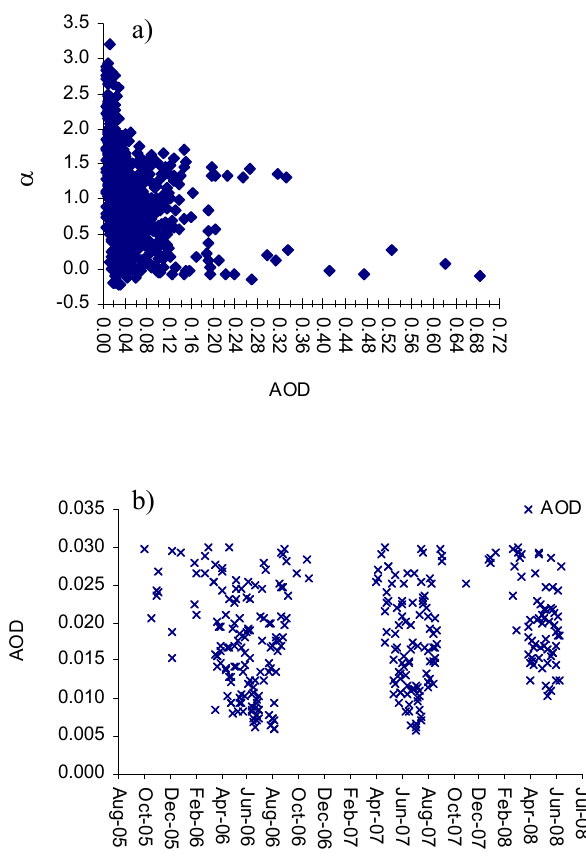
Fig. 4. (a) Scatter plot of daily means of α (440–870nm) vs. daily means of AOD. (b) Daily means of AOD less than